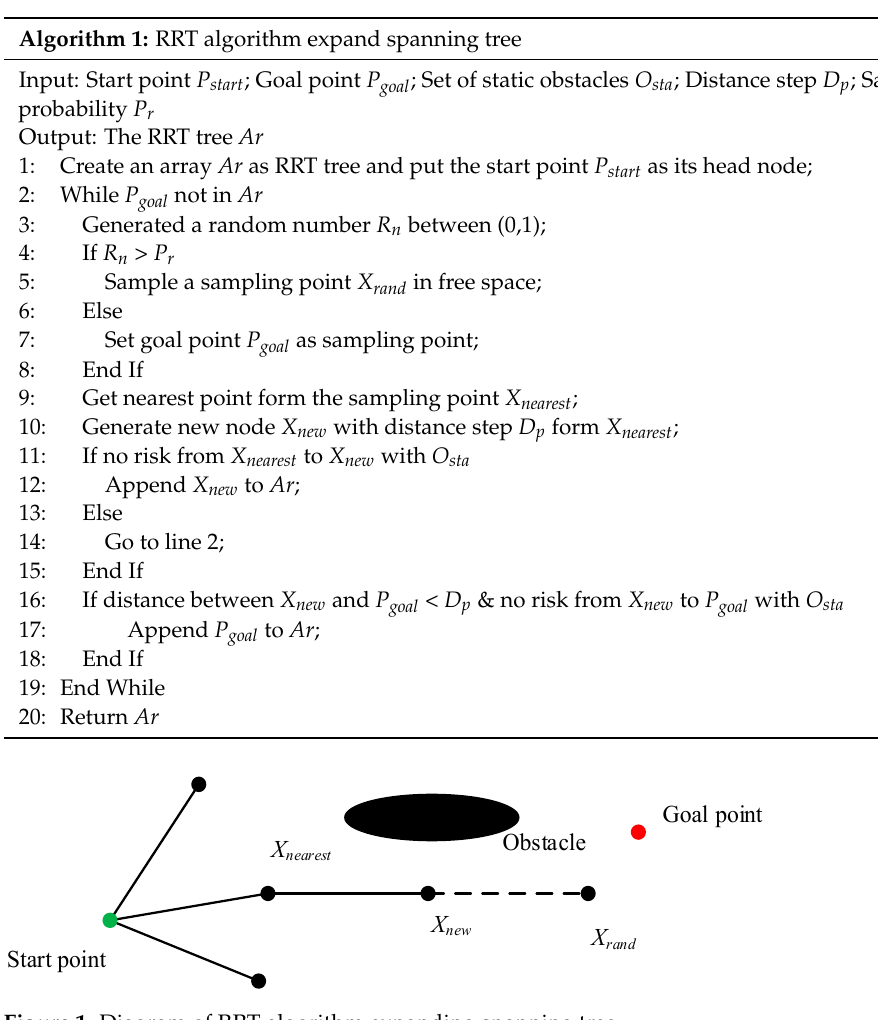
Figure 1. Diagram of RRT algorithm expanding spanning tree. Algorithm 1: RRT algorithm expand spanning tree